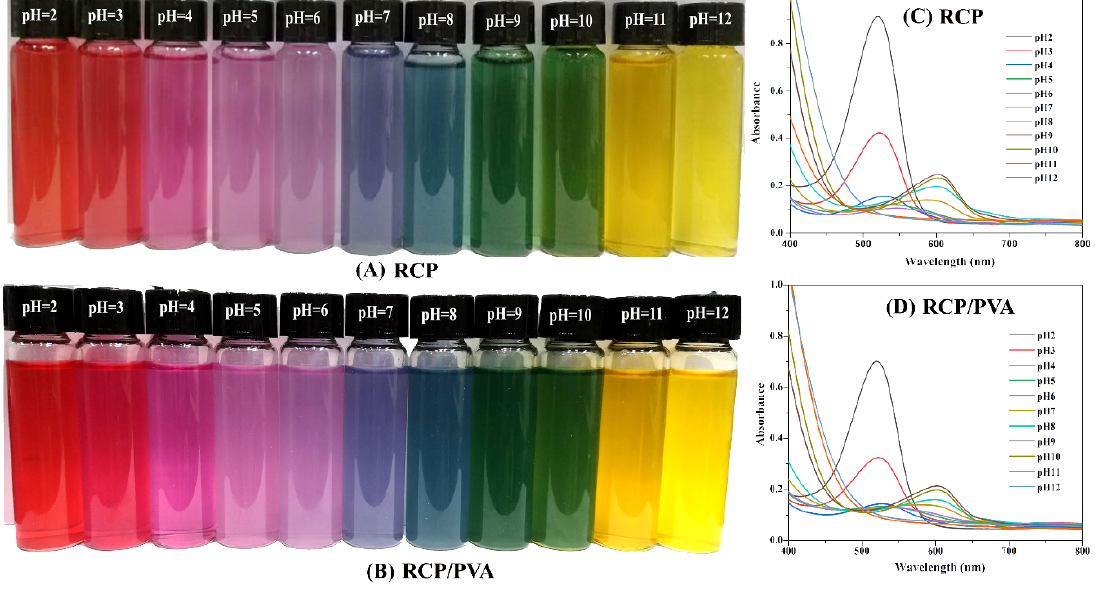
Figure 3. Color variations ( A , B ) and UV − Vis spectra ( C , D ) of the RCP and RCP/PVA suspensions in a pH range of 2–12. a pH range of